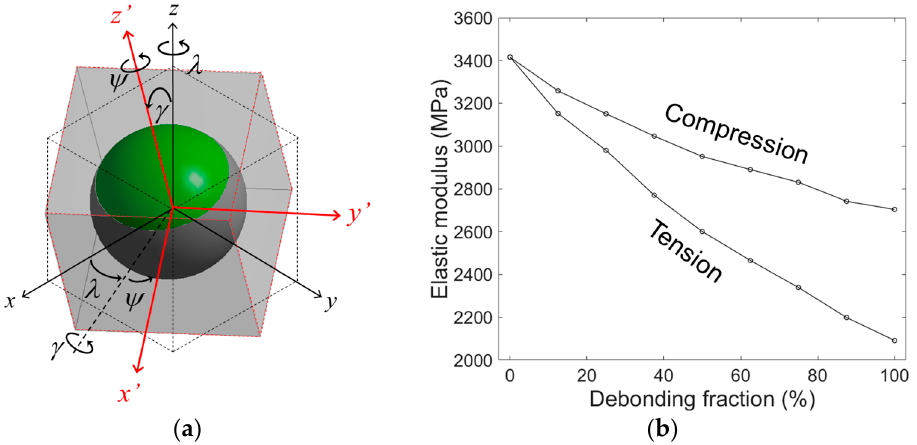
Figure 9. ( a ) Schematic of rotation of coordinates and ( b ) elastic moduli of the partially debonded model with random orientation of debonding direction.